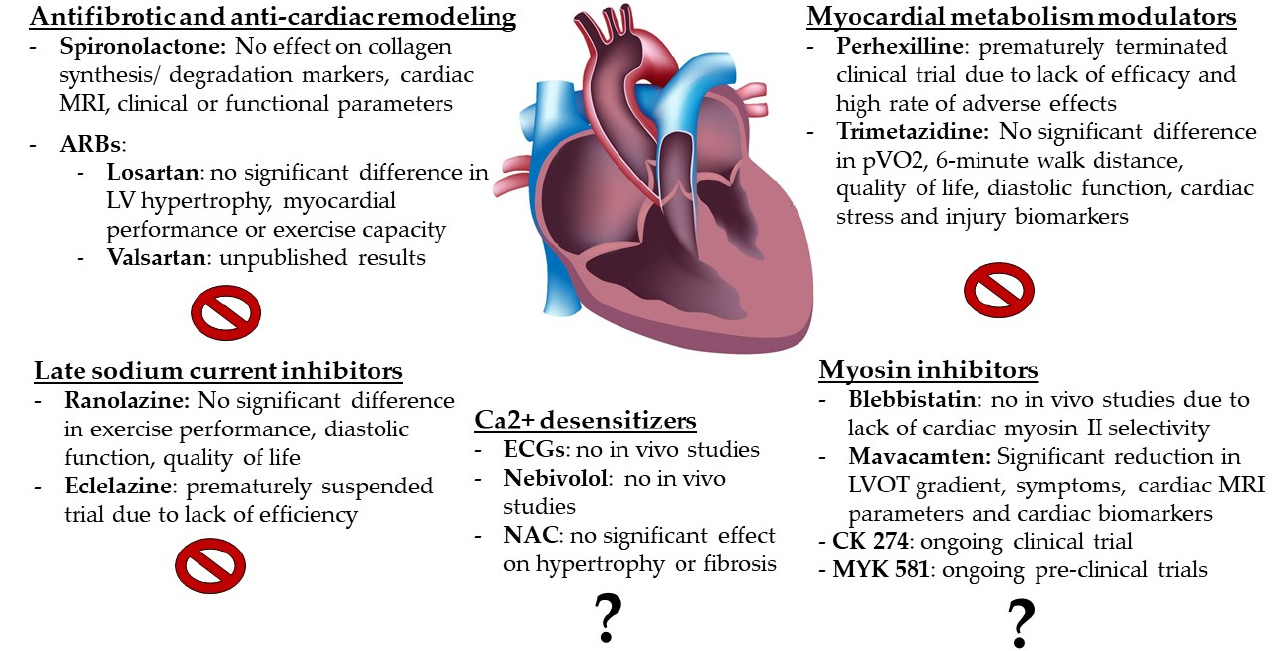
Figure 1. Targeted mechanisms of pharmacological therapy for HCM. ARBs = angiotensin II receptor blockers; ECGs = Epigallocatechin-3-gallate; LV = left ventricle; LVOT = left ventricle outflow tract; MRI = magnetic resonance imaging; NAC = N-acetylcysteine; pVO2 = peak oxygen consumption.